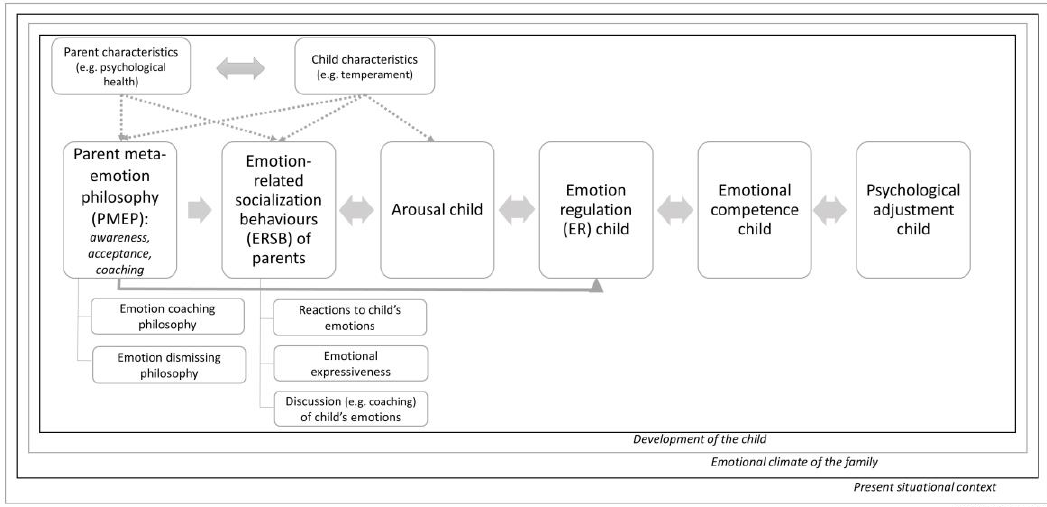
Figure 1. Summarizing theoretical framework.